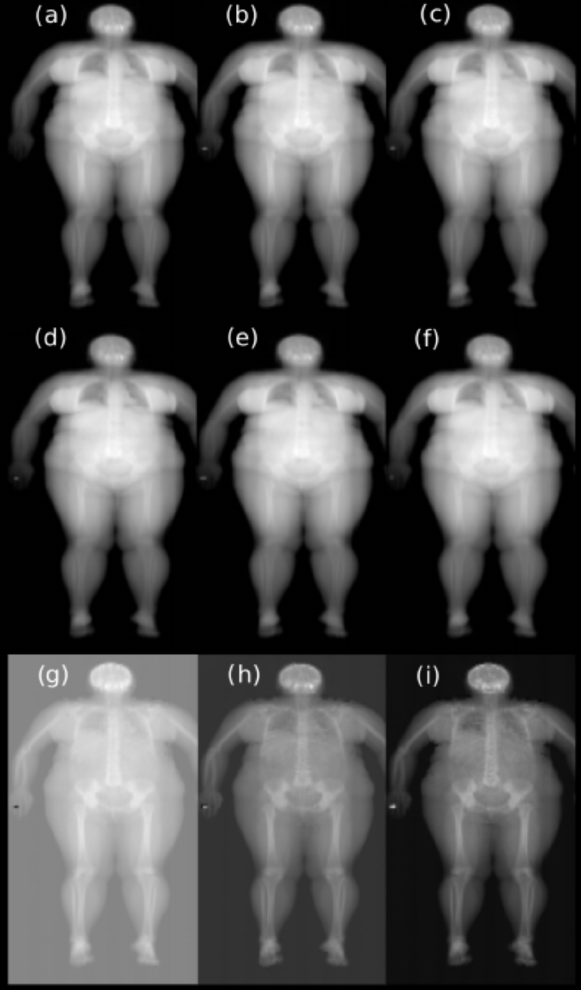
Figure 1. The first six images correspond to low- and high-energy beams passing through different segments of the filter and the patient: ( a ) low air, ( b ) low tissue, ( c ) low bone, ( d ) high air, ( e ) high tissue, ( f ) high bone. Images ( g – i ) are a result of the subtraction of high-energy images from low- energy